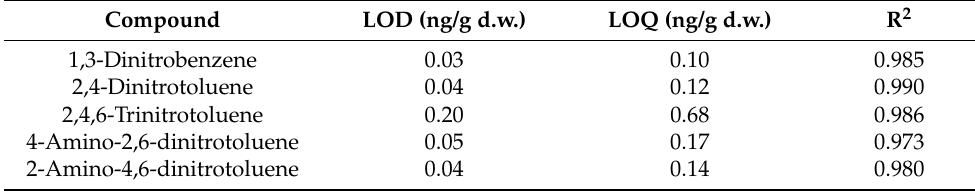
Table 2. Limits of detection (LODs) and quantification (LOQs) of the method used [47]. Compound